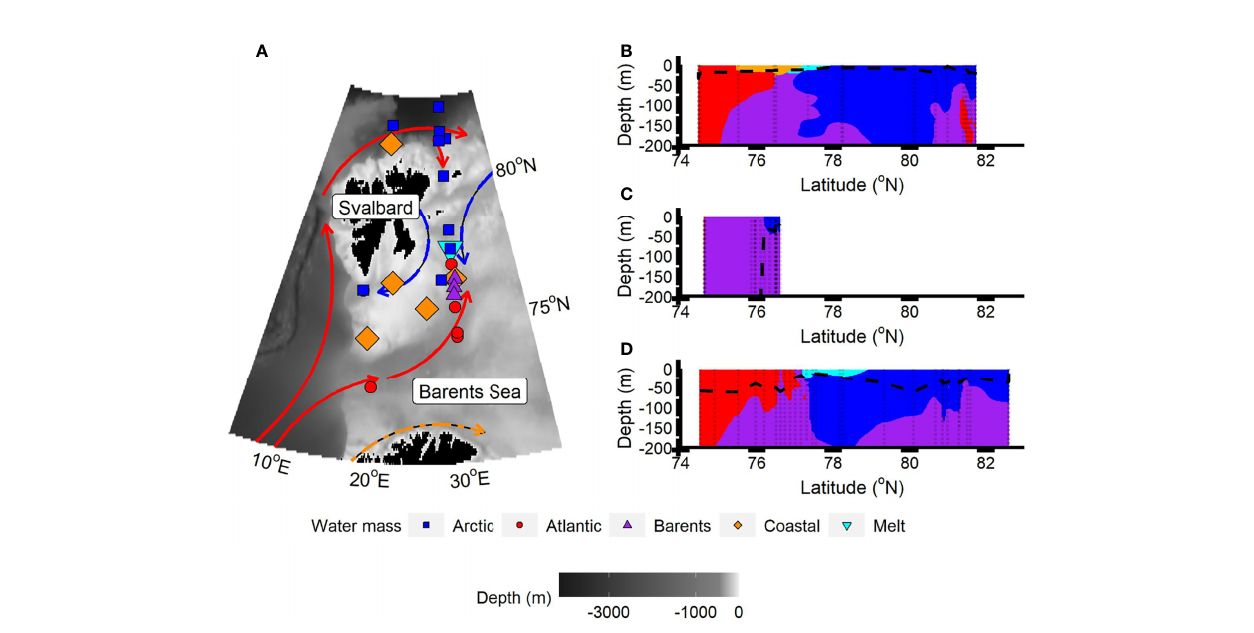
FIGURE 1 | (A) Map of phytoplankton samples considered in this study. In fl owing Atlantic, Arctic and coastal water masses are represented with solid red, dashed blue and dot-dashed orange arrows. Right; from top to bottom: (B) JR16006 (summer 2017), (C) HH180423 (spring 2018), (D) JR17006 (summer 2018). Water masses: Arctic Water (blue), Atlantic Water (red), Barents Sea Water (purple), Coastal Water (orange) and Melt Water (cyan). The mixed layer depth, de fi ned in accordance with Peralta-Ferriz and Woodgate (2015), is represented by a dashed black line. Vertical dotted lines represent CTD pro fi